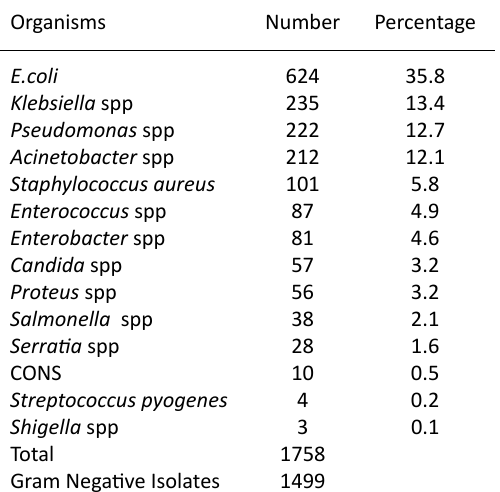
Table 2. Distribution of organisms